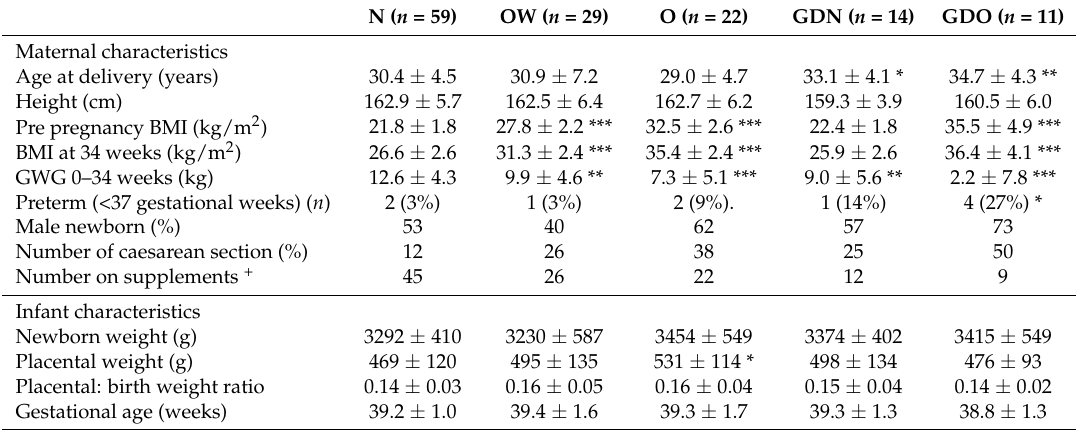
Table 1. Summary of maternal age, body and birth weights of all